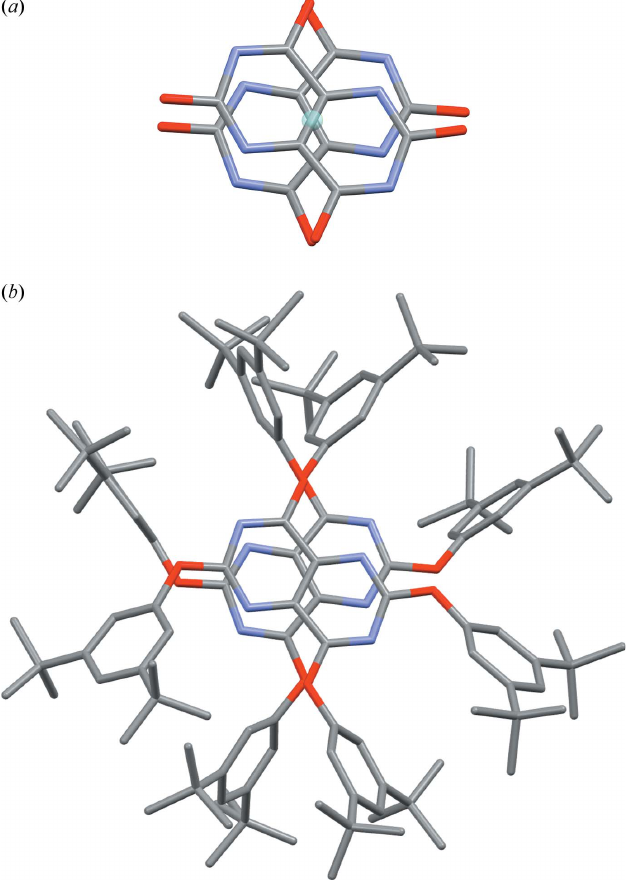
Figure 3 ( a ) View of the molecule A and molecule B pyrimido[5,4- d ]pyrimidine cores, viewed down the overlapping C5 A —C6 A and C5 B —C6 B centroids; ( b ) as ( a ) with the side chains included.